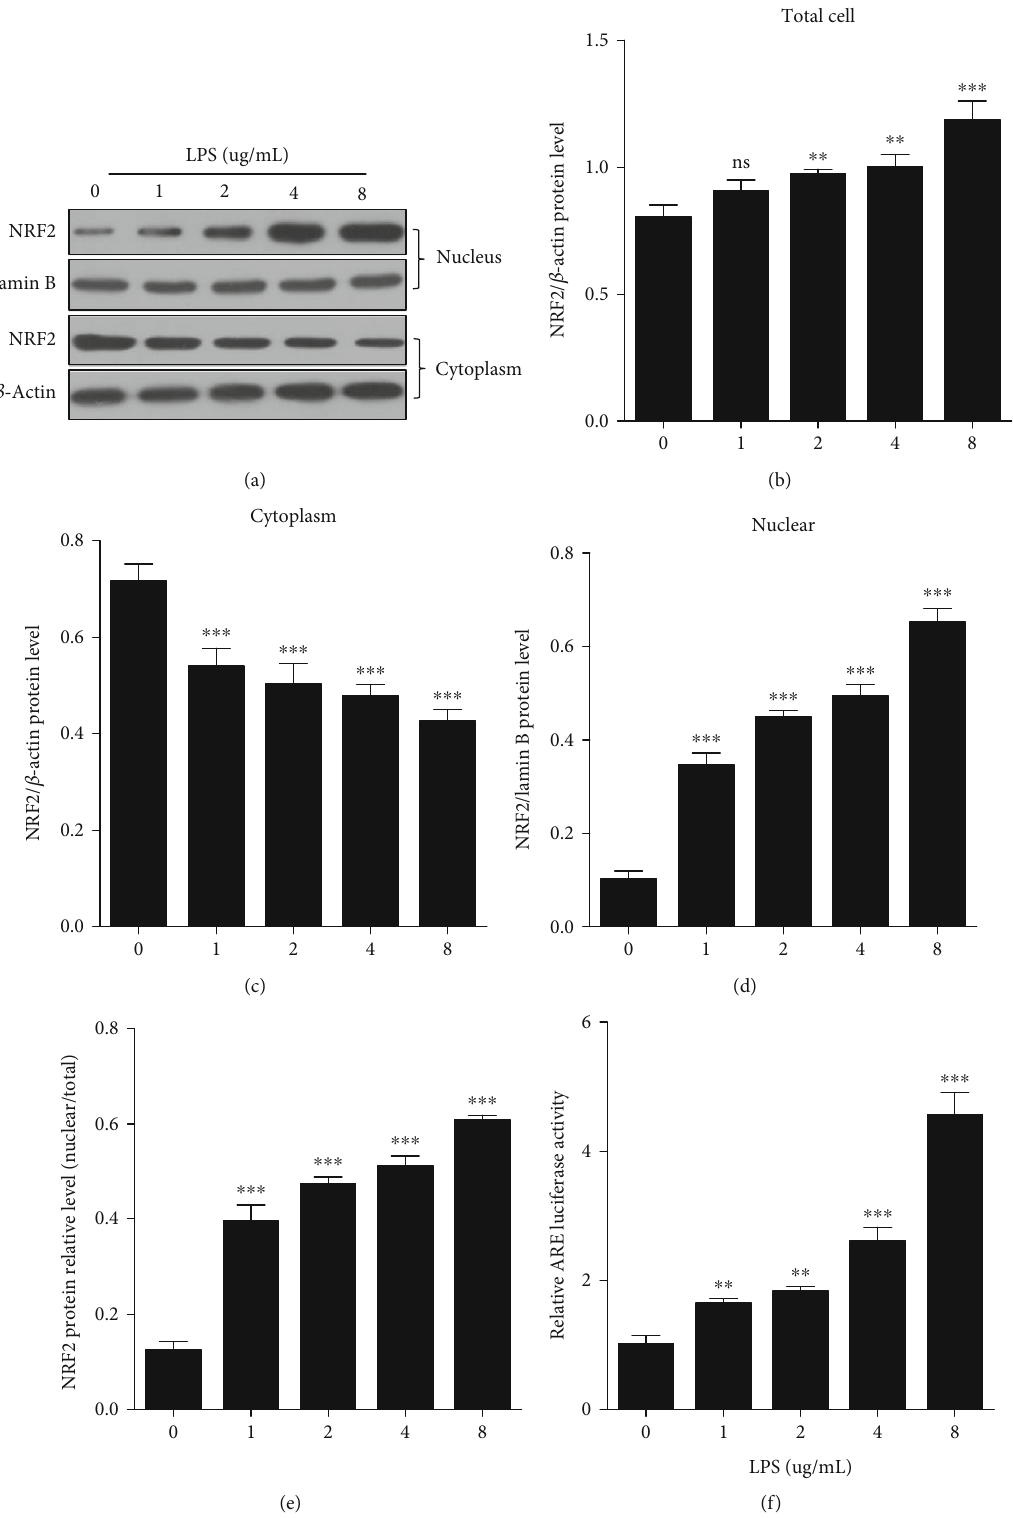
Figure 1: Induction of NRF2 in gEECs induced by LPS. GEECs were exposed to di ff erent concentrations of lipopolysaccharide (LPS) for 12 hours and then detected the expression of NRF2 protein by immunoblotting. (a) Representative NRF2 protein band was quanti fi ed in (b) total cells, (c) cytoplasm, (d) nucleus, and (e) the ratio of nuclear/total cells, and we also detected ARE luciferase activity (f). Data shown are mean ± SD , and ns was P > 0 : 05 , ∗∗ was P < 0 : 01 , and ∗∗∗ was P < 0 : 001 vs. LPS = 0 μ g/mL . P value was calculated by the one-way ANOVA with Tukey ’ s test as a posthoc